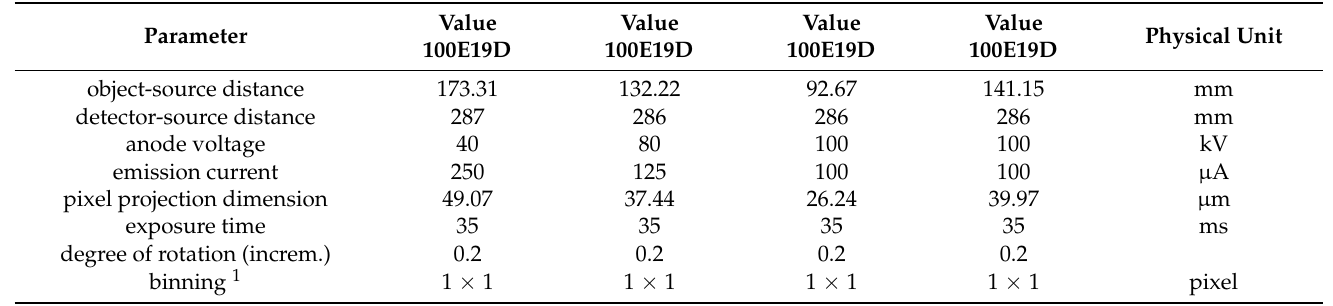
Table A7. Values of set parameters on SkyScan